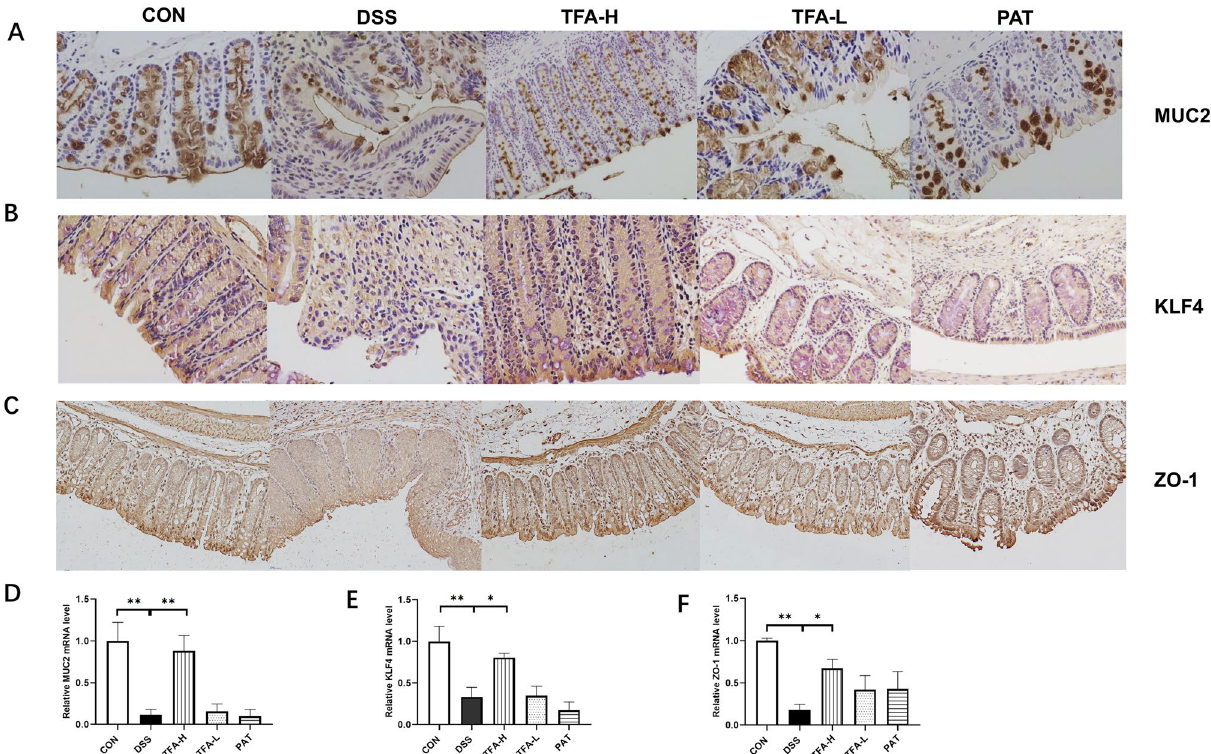
Figure 3. Recovery of mucus‑ and tight junction‑associated proteins from the colons of DSS‑induced colitis mice by TFA and PAT. ( A ) The number of colonic MUC2‑positive cells in DSS‑treated mice. Representative images (× 200 magnification, scale bar 50 μm). ( B ) The number of colonic KLF4‑positive cells in DSS‑treated mice. Representative images (× 200 magnification, scale bar 50 μm). ( C ) The number of colonic ZO‑1‑ positive cells in DSS‑treated mice. Representative images (× 200 magnification, scale bar 50 μm). ( D ) mRNA quantification of MUC2. ( E ) mRNA quantification of KLF4. ( F ) mRNA quantification of ZO‑1. The data present the mean ± S.E.M. and n = 5/group. * P < 0.05, ** P < 0.01, *** P < 0.001, # P < 0.0001.